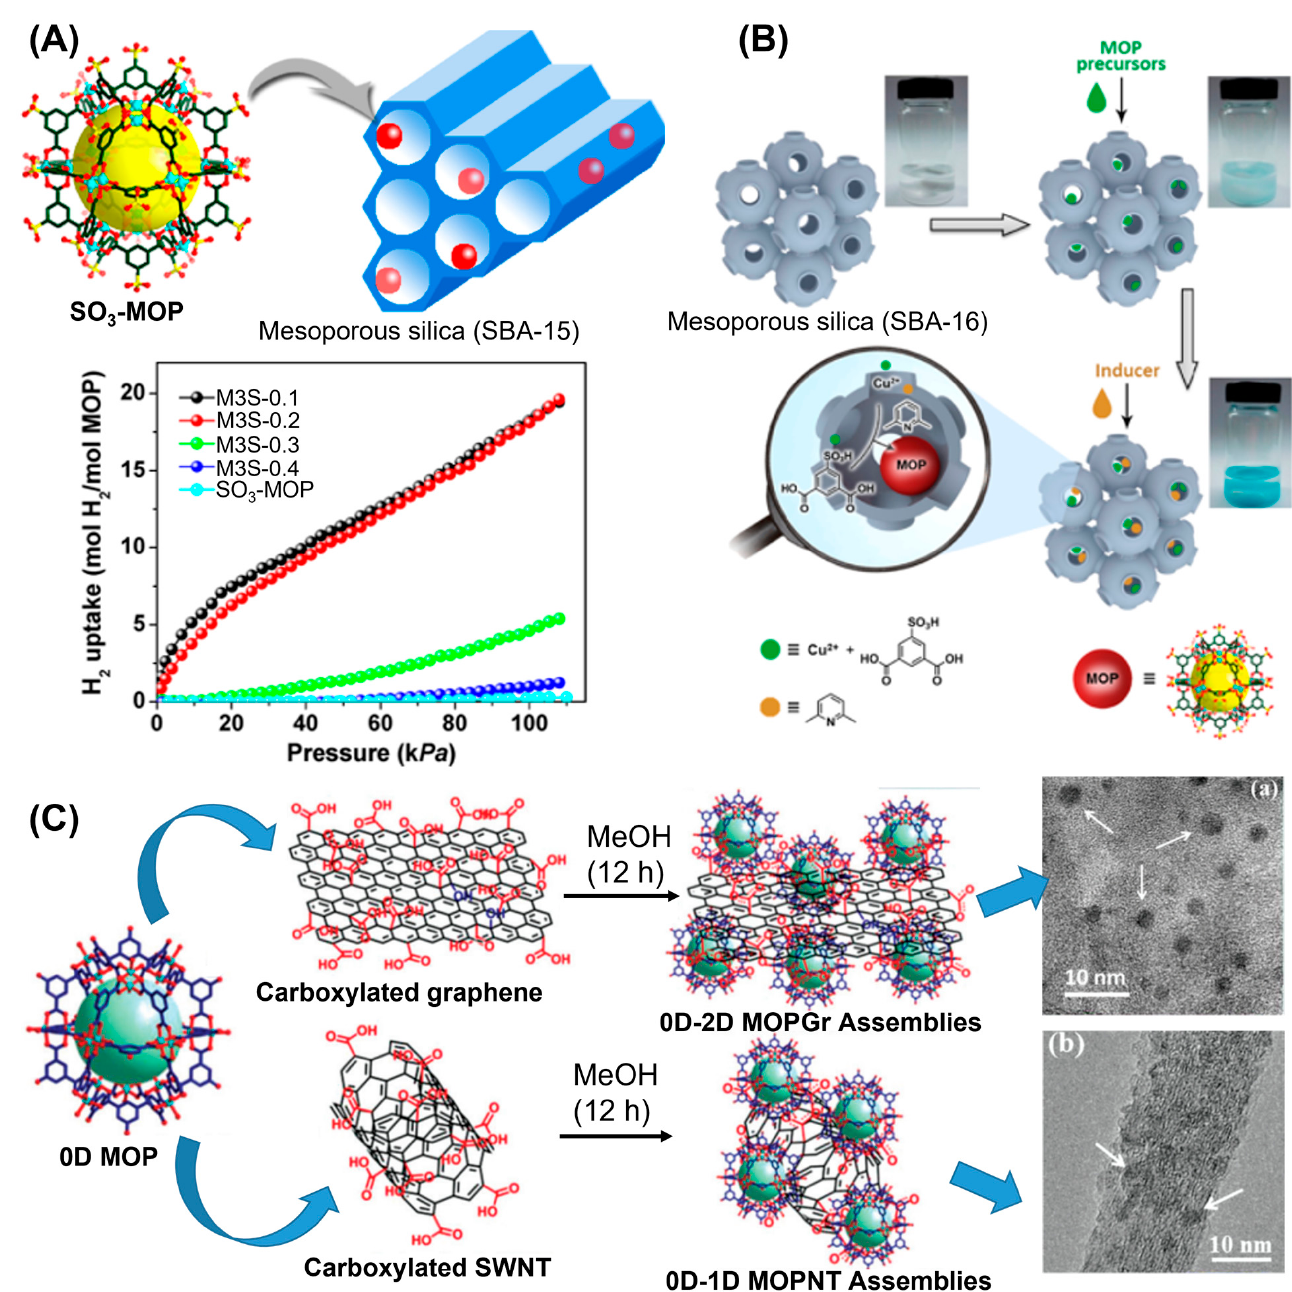
Figure 16. ( A ) Illustration of dispersion of sulfonated MOP in silica nanopores. H 2 adsorption capacities of M3S and SO 3 -MOP samples at 77 K are shown. The adsorption capacities of M3S samples (mol of H 2 /mol of MOP) were calculated by subtracting the uptake of the SBA-15 support from the measured uptake. ( B ) Schematic representation of the synthesis of MOP-SO 3 H in mesoporous silica cavities (SBA-16) by using a double-solvent strategy. Dispersion of SBA-16 in hydrophobic n-hexane. Addition of a hydrophilic solution of MOP precursors in methanol (metal ions and ligands) followed by addition of the inducer (base) for MOPs formation. ( C ) Schematic representation of the synthesis of MOPGr and MOPNT assemblies. Reprinted by permission from Refs. [77,149,150]. Copyright 2012 and 2016 from American Chemical Society. Copyright 2017 from Royal Society of